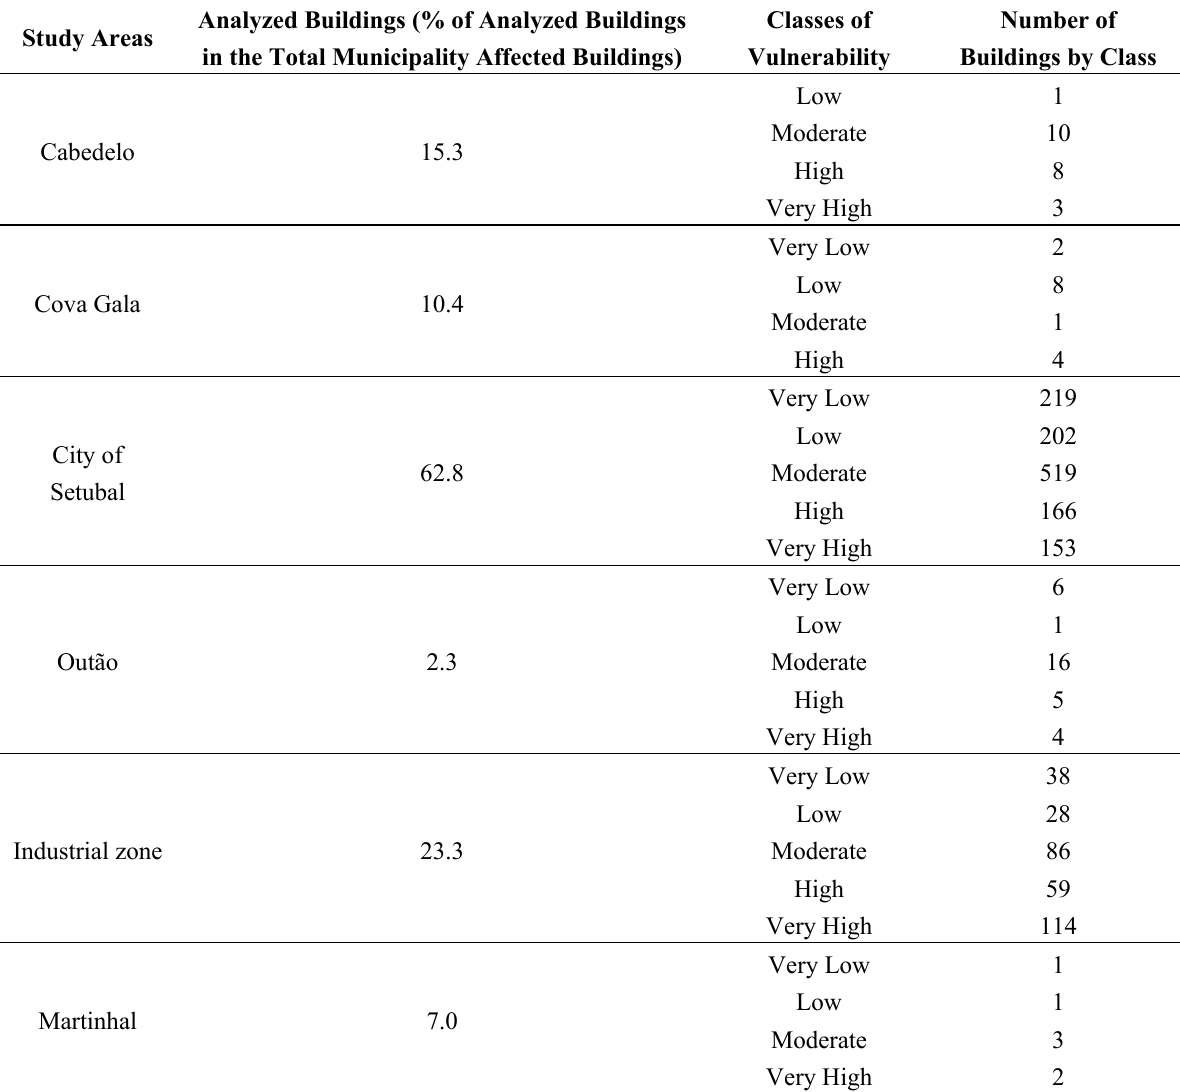
Table 6. Percentage and number of buildings by classes of